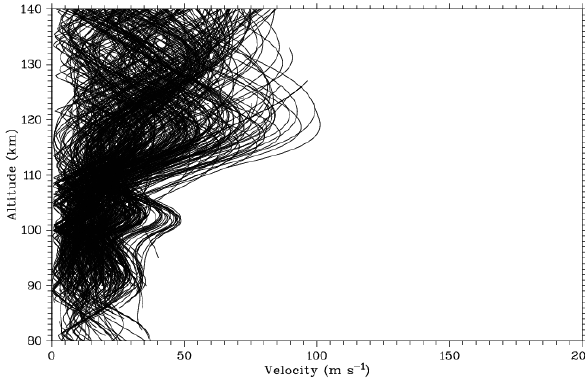
Fig. 3. The Horizontal Wind Model neutral wind magnitude profiles corresponding to the profiles shown in Fig.